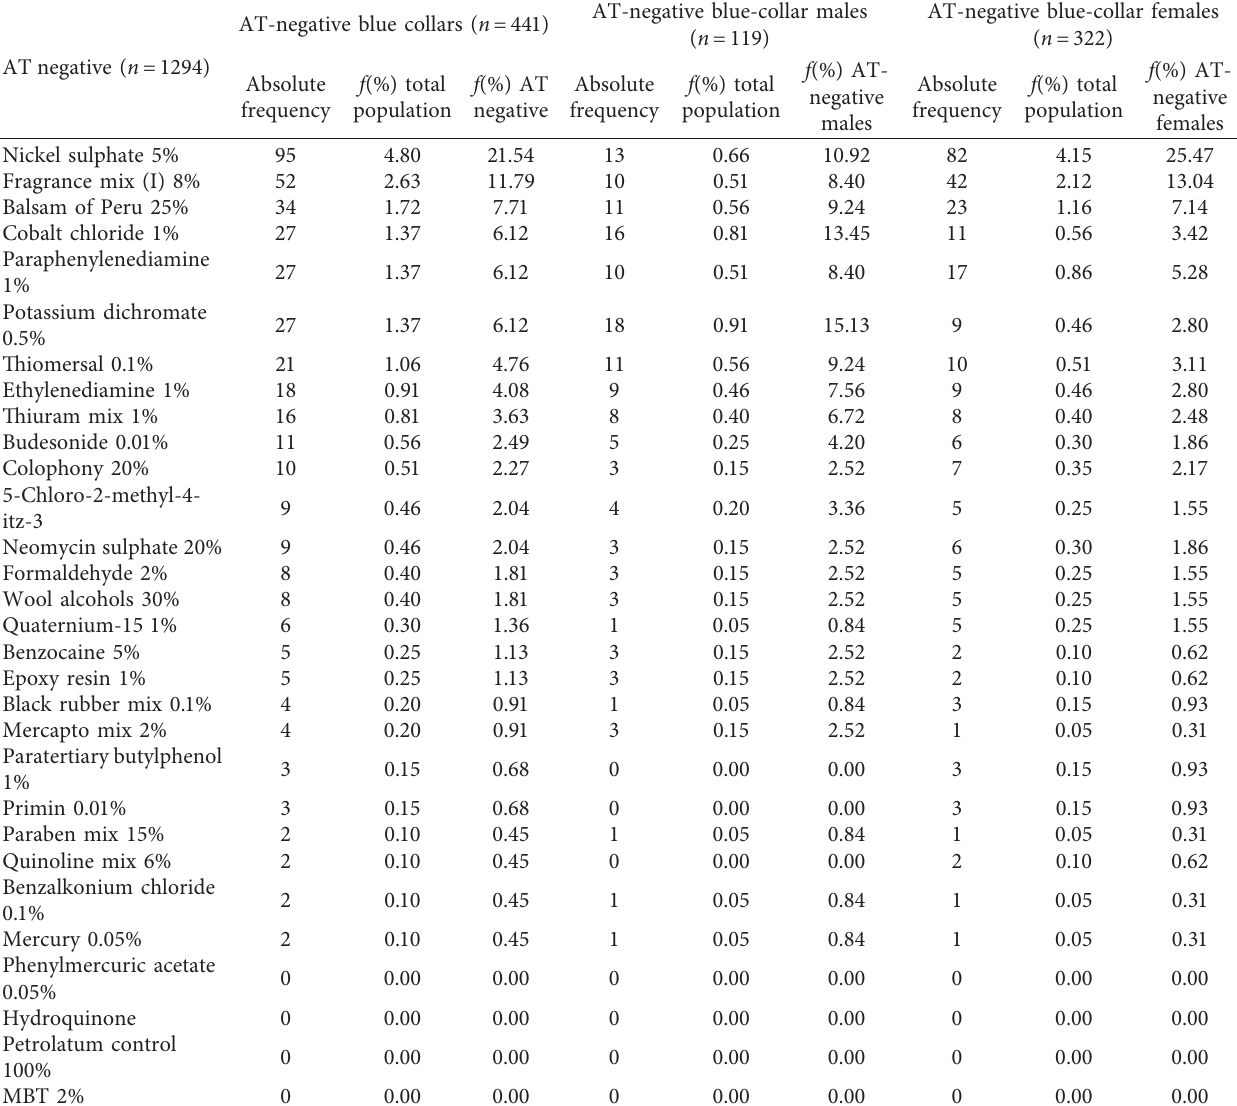
Table 4: Frequencies of the most prevalent allergens in the population without atopic dermatitis (AT), with respect to the blue-collar (BlC) population, as well as the male and female BlC